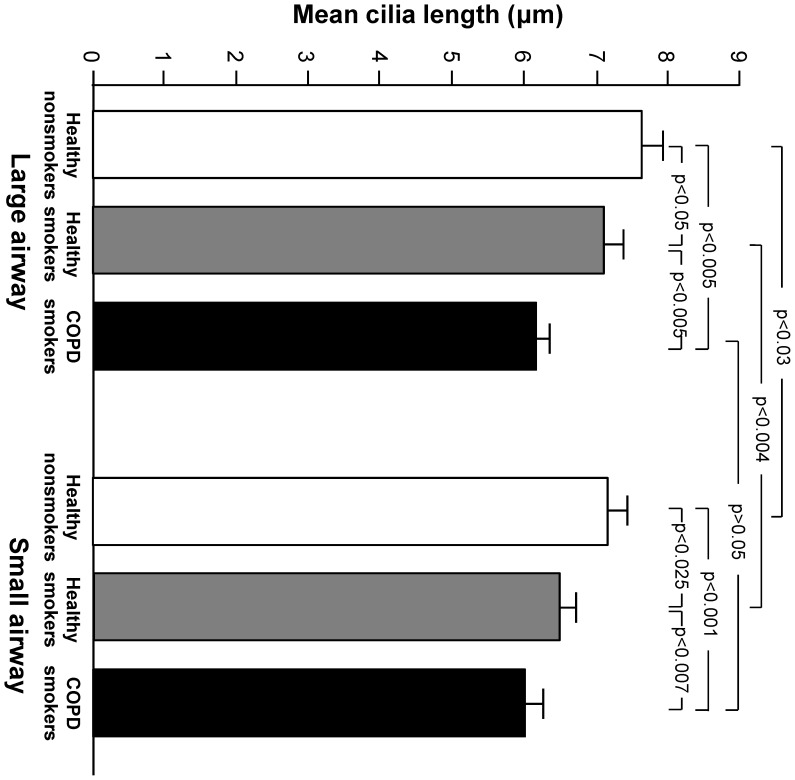
Cilia length in the large and small airway of nonsmokers, healthy smokers, and COPD smokers.Mean cilia length in micrometers is displayed on the ordinate. The abscissa displays large airway on the left and small airway on the right, with healthy nonsmokers represented in white, healthy smokers in dark gray, and smokers with COPD in black. Error bars show the standard error of the mean for each phenotype. Within the large airway, n = 120 (healthy nonsmokers n = 25, healthy smokers n = 25, smokers with COPD n = 70). Within the small airway, n = 108 (healthy nonsmokers n = 20, healthy smokers n = 32, smokers with COPD n = 56). There are significant differences in mean cilia length between all phenotypes in both the large and small airway (p<0.05). There are significant differences in mean cilia length between airway locations in both healthy nonsmokers and healthy smokers (p<0.05).